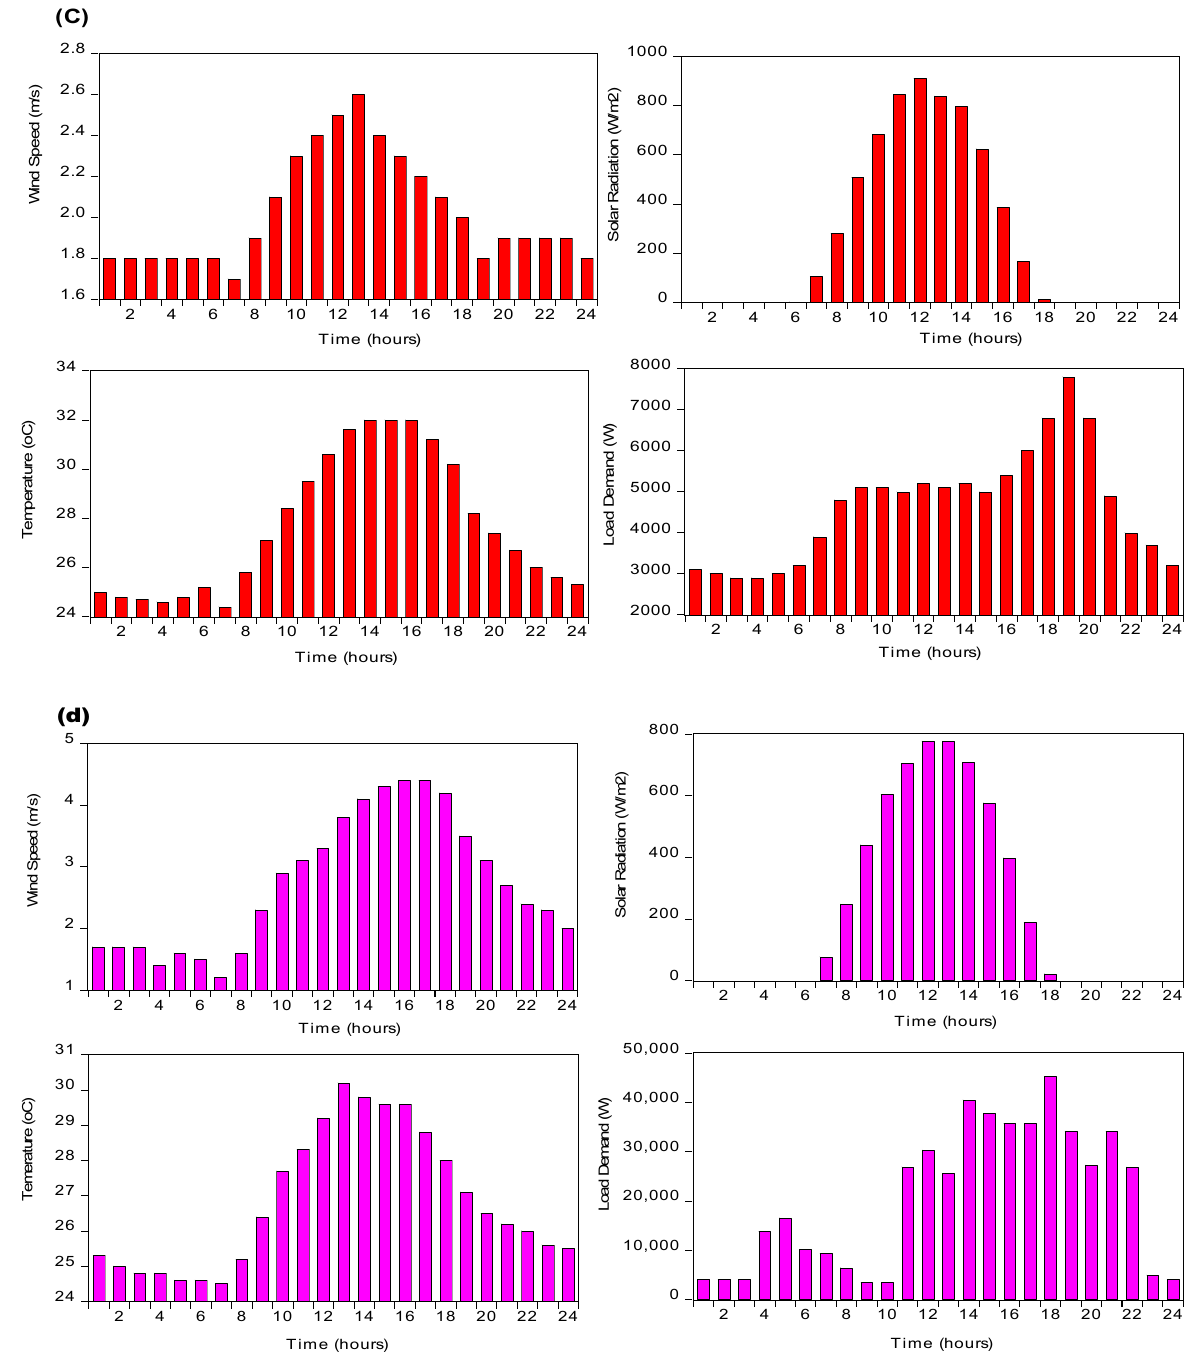
Figure 5. Bar plot of the raw data for ( a ) Kano, ( b ) Abuja, ( c ) Niger, and ( d ) Lagos. Although the selection of input variable combination is effective using linear sensi- tivity analysis, many studies such as [39–42] criticized the conventional method of using Pearson correlation as the input selection approach and recommended the application of complex chaotic systems such as non-linear kernels, GA, and kernel-PCA. In this study,